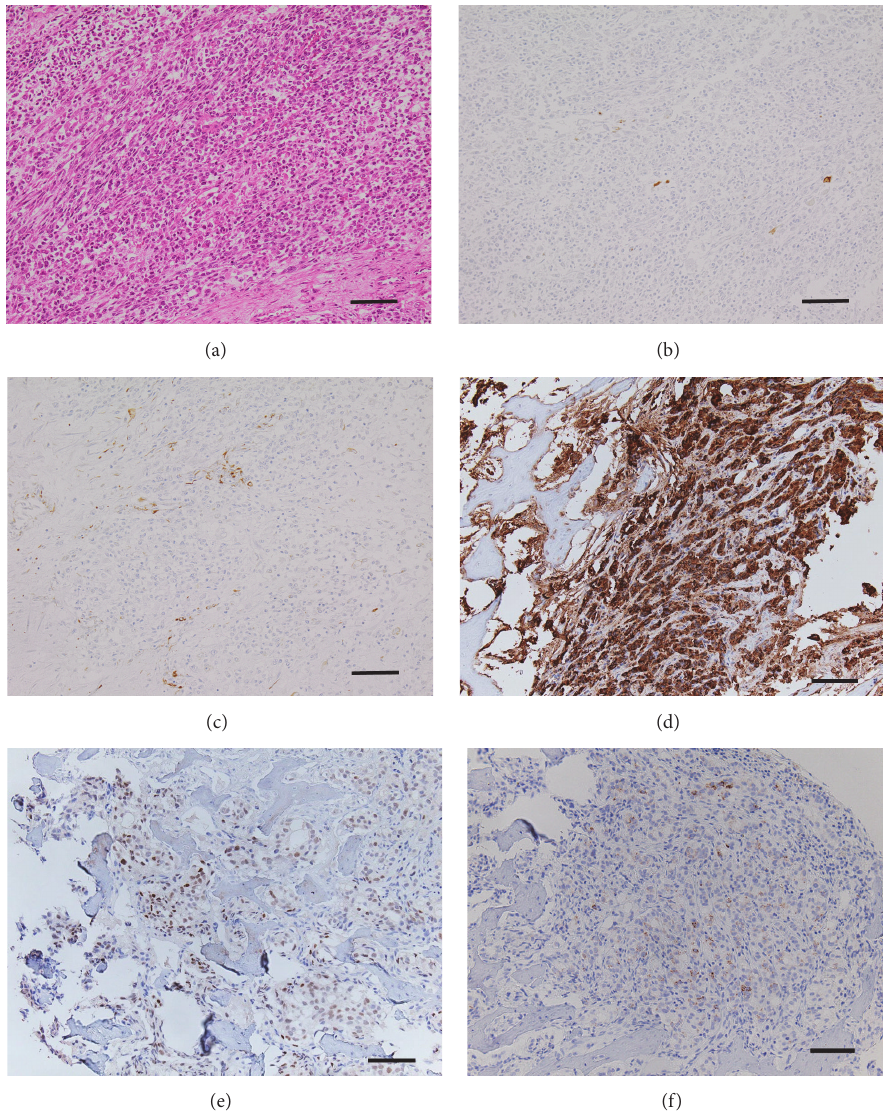
Figure 3: Staining with (a) hematoxylin and eosin ( × 20), (b) CAM5.2, (c) vimentin, (d) prostate specific acid phosphatase, and (e) androgen receptor showed small-sized but pleomorphic anaplastic tumor cells. (f) Reticulin silver impregnation showed epithelioid-like structures, indicative of carcinoma (bar: 100 𝜇